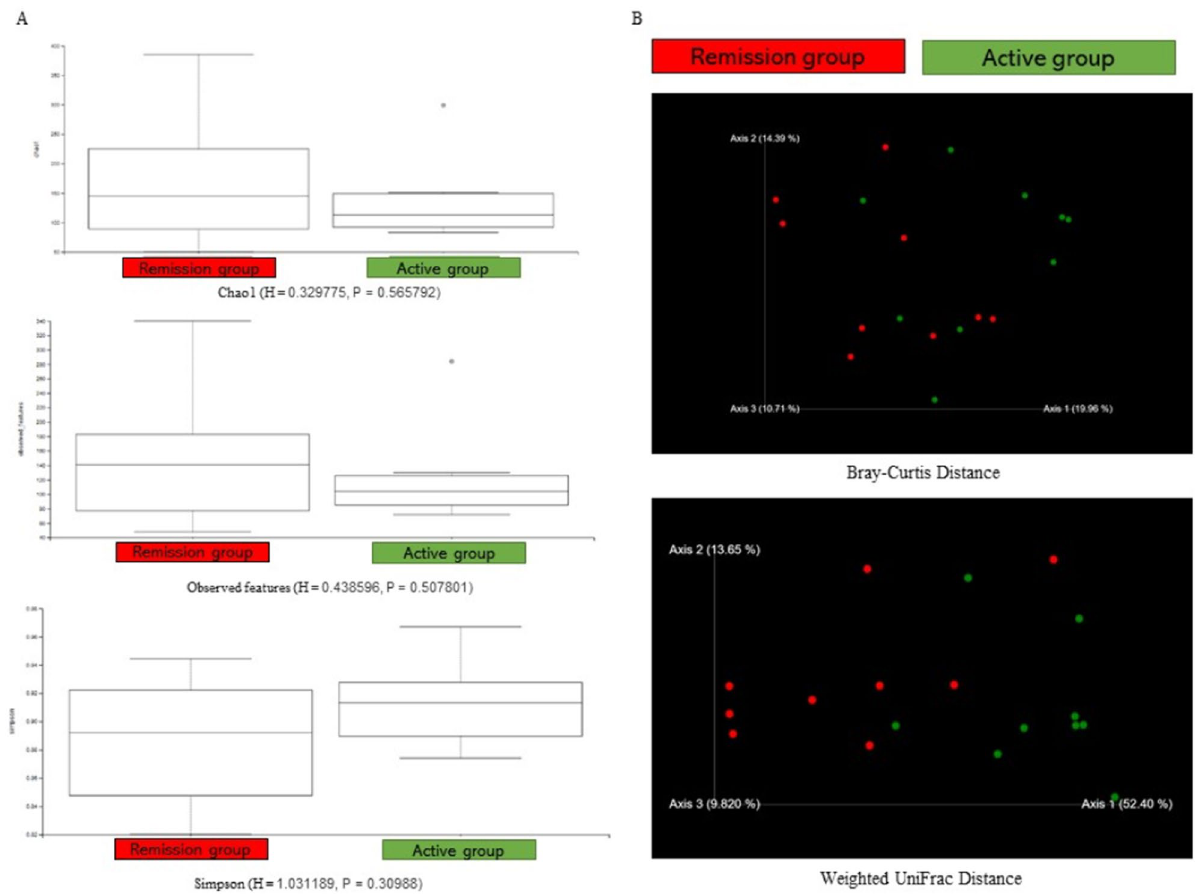
Figure 2. The oral microbiota difference between the active group (n = 9) and the remission group (n = 9). ( a ) Calculation of alpha diversity values (Chao1, observed features, and Simpson) for comparison of the total microbial diversity of peri-implantitis between the active group (n = 9) and the remission group (n = 9). ( b ) The principal coordinate analysis charts based on Bray–Curtis and weighted UniFrac distance: comparisons between the two